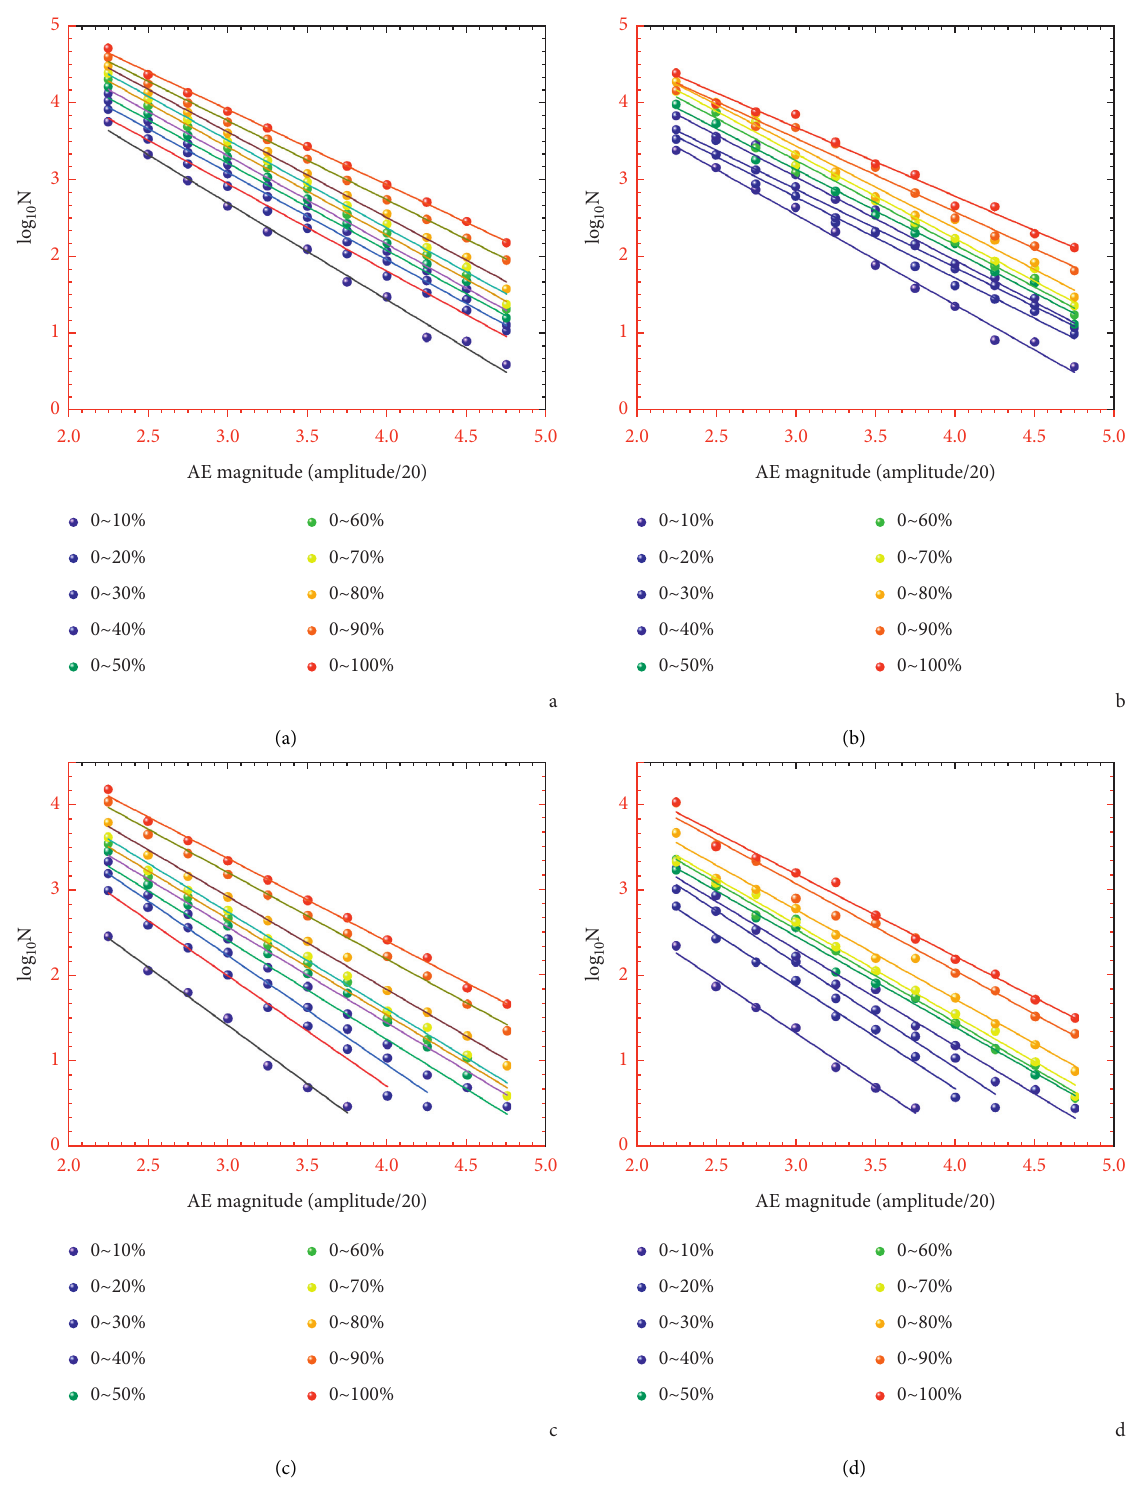
Figure 5: Cumulative frequency amplitude distribution of acoustic emission of raw coal sample with parallel bedding. (a) V1-1, (b) V1-2, (c) P2-1, and (d)